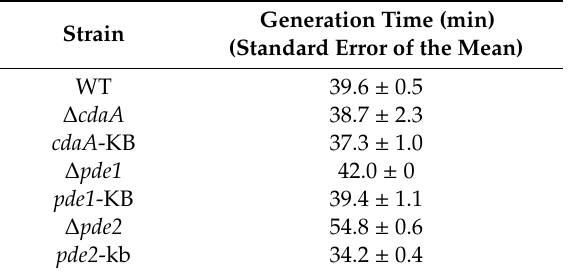
Figure 5. Disruption of the c-di-AMP signaling network affects colony morphology. Mutants and WT were grown on blood agar plates overnight in a humidified atmosphere containing 5% CO 2 . All mutants were grown on the same plate, and well-separated colonies were magnified. The brightness and contrast of the magnified pictures were manipulated to improve the contours of the colonies. The colors of the colonies and hemolysis are therefore not representative.